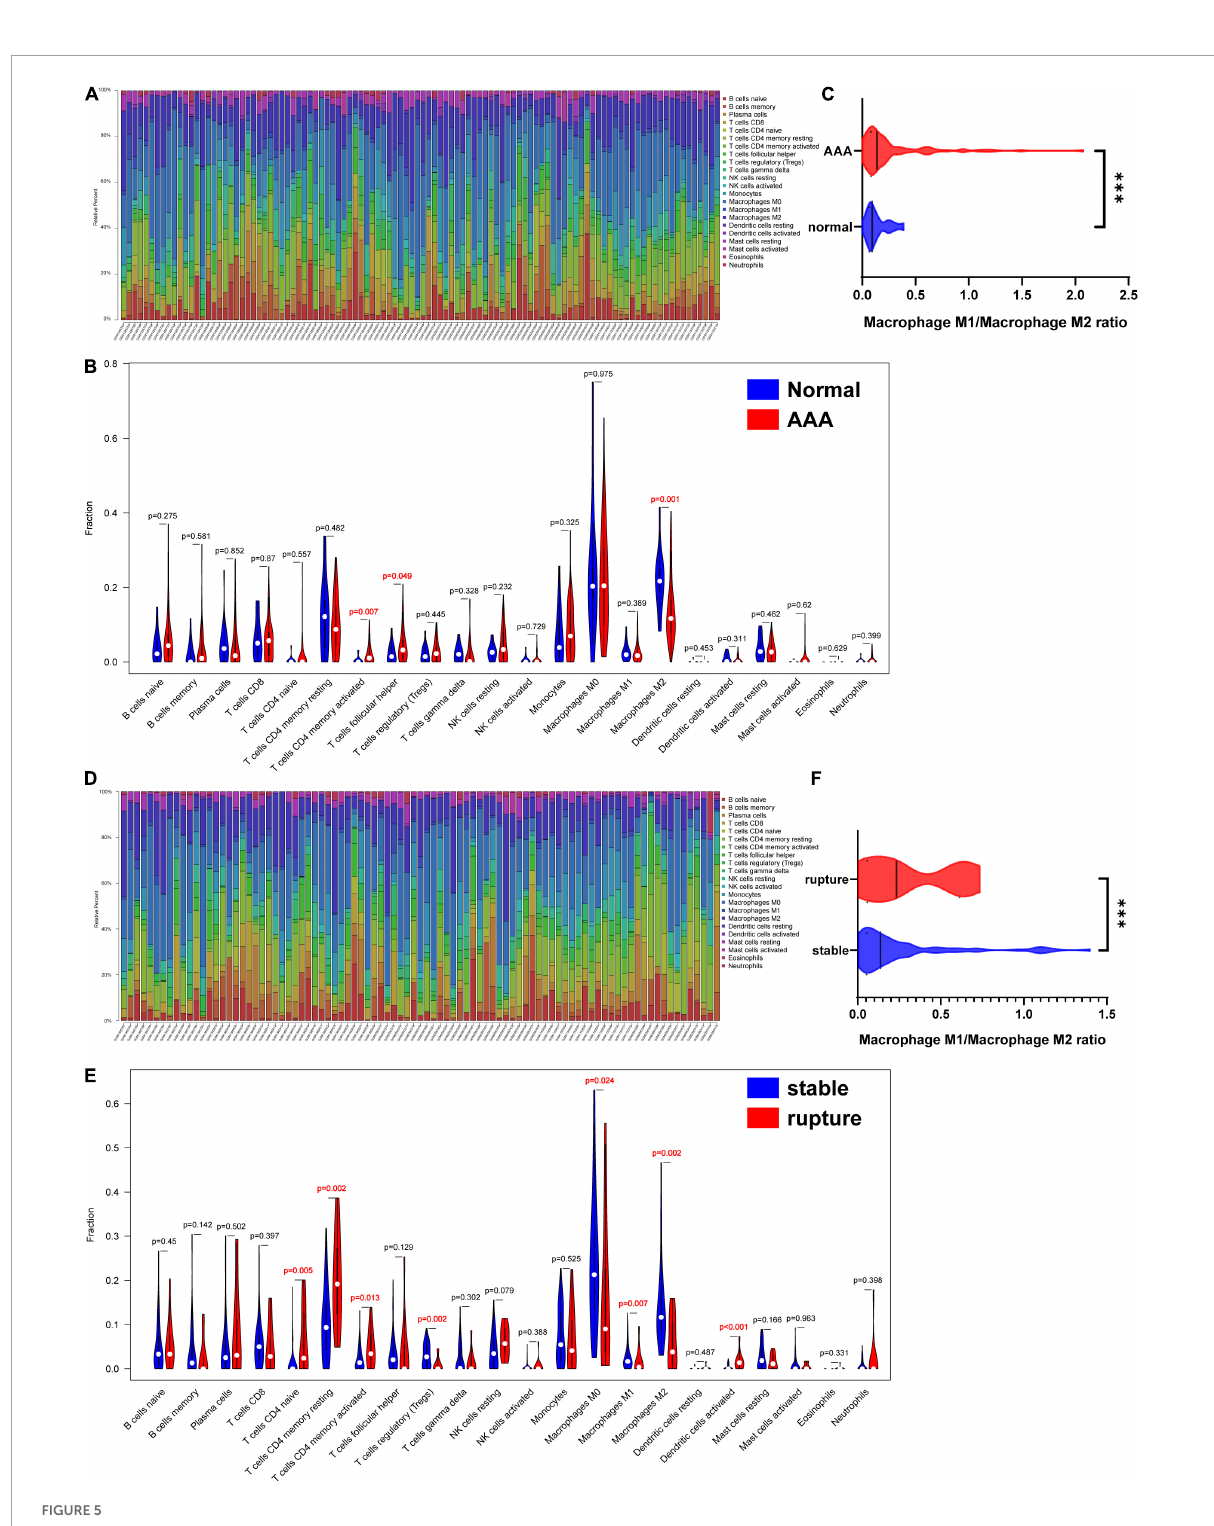
FIGURE5 Infiltration of immune cells in different samples. (A) Proportion of 22 kinds of immune cells in samples of AAA-related merged dataset 1. (B) The difference of infiltration of immune cells between normal abdominal aorta group and AAA group. The numbers in red represented p -value < 0.05. (C) The macrophage M1/macrophage M2 ratio in normal abdominal aorta group and AAA group. (D) Proportion of 22 kinds of immune cells in samples of aortic rupture-related merged dataset 2. (E) The difference of infiltration of immune cells between stable AAA group and aortic rupture group. The numbers in red represented p -value < 0.05. (F) The macrophage M1/macrophage M2 ratio in stable AAA group and aortic rupture group. AAA, abdominal aortic aneurysm. *** p <